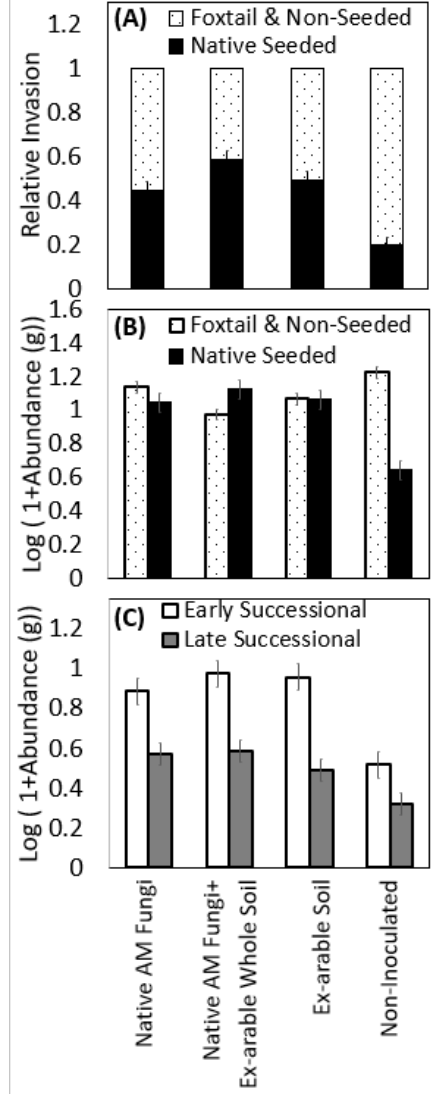
Figure 4. The effect of inoculation treatment on ( A ) the relative invasibility (proportion of native vs. non-native plants) and ( B ) the abundance (Log (1 + aboveground biomass)) of native (black bars) versus non-native plants ( S. faberi (foxtail) and non-seeded; white patterned bars), and ( C ) the abundance of seeded early successional (white bars) and late successional plants (grey bars). Bars represent the LS means of plant growth and error bars are standard error from the Proc GLM models.